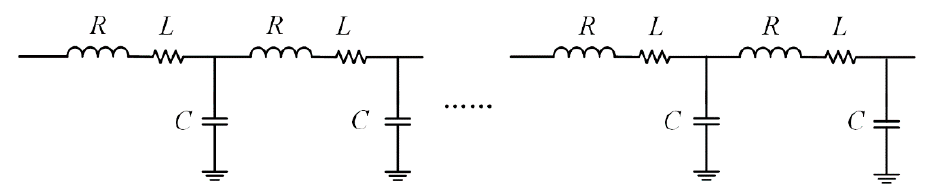
Figure 7. Lumped parameter cascade model of a transmission cable.